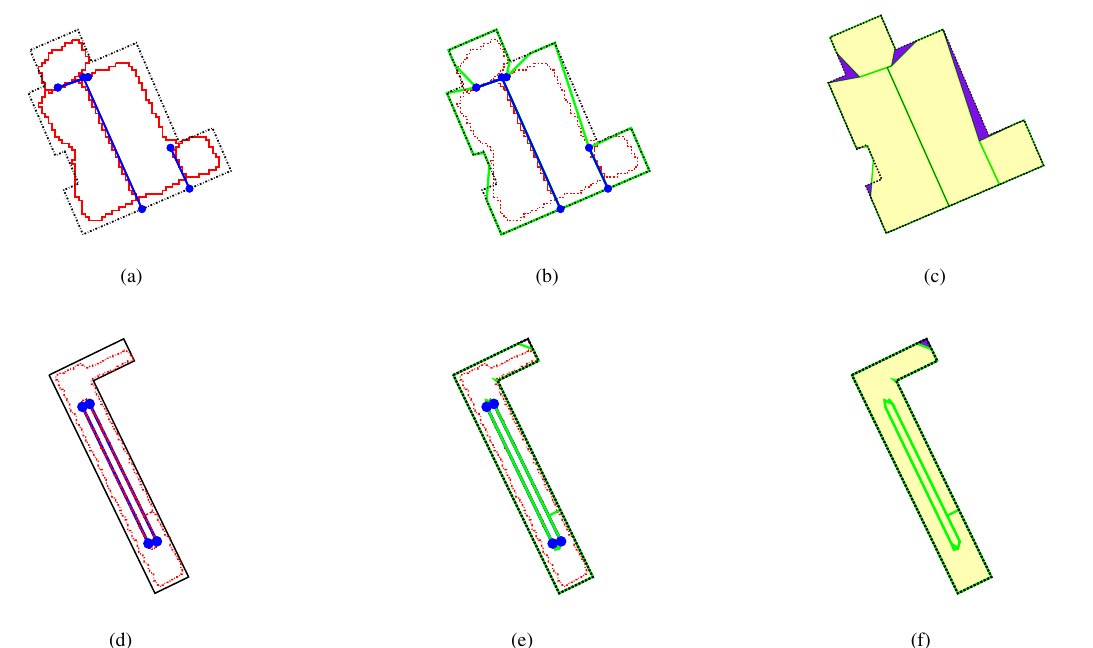
Figure 10. 2D representation of building outline and bordering roof polygons of two buildings of the data set Meppen. Left column: generated building outlines (black), initial bordering plane polygons (red) and corresponding cut lines and step lines (blue); middle column: aligned bordering plane polygons (green); right column: The covered area is depicted in yellow. The purple areas are missing firstly but can be added by processing uncovered